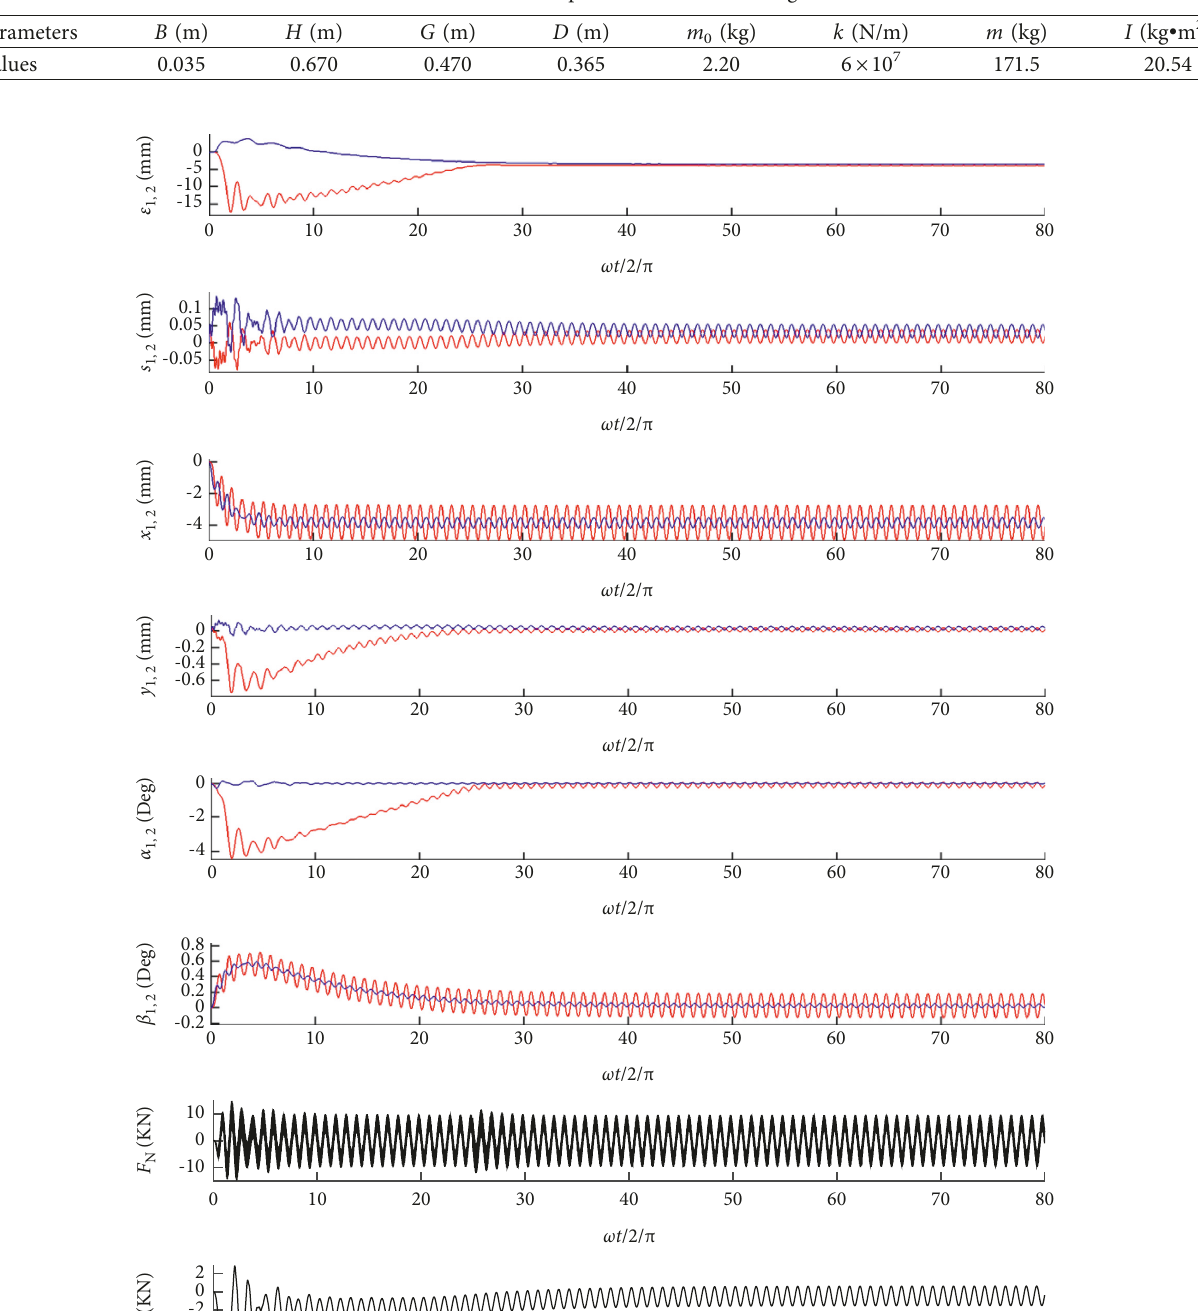
Table 1: Structural inherent parameters of the testing machine.